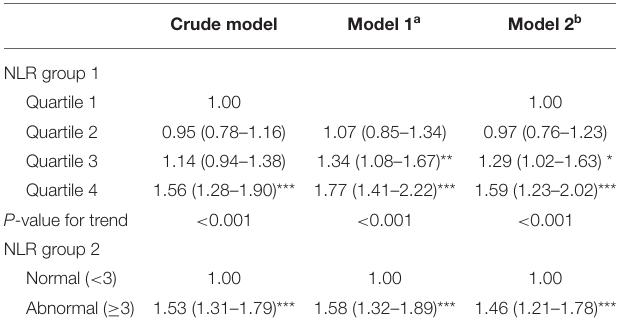
TABLE 2 | Cross-sectional association of NLR with frailty in community-dwelling older adults of the CLHLS ( n =